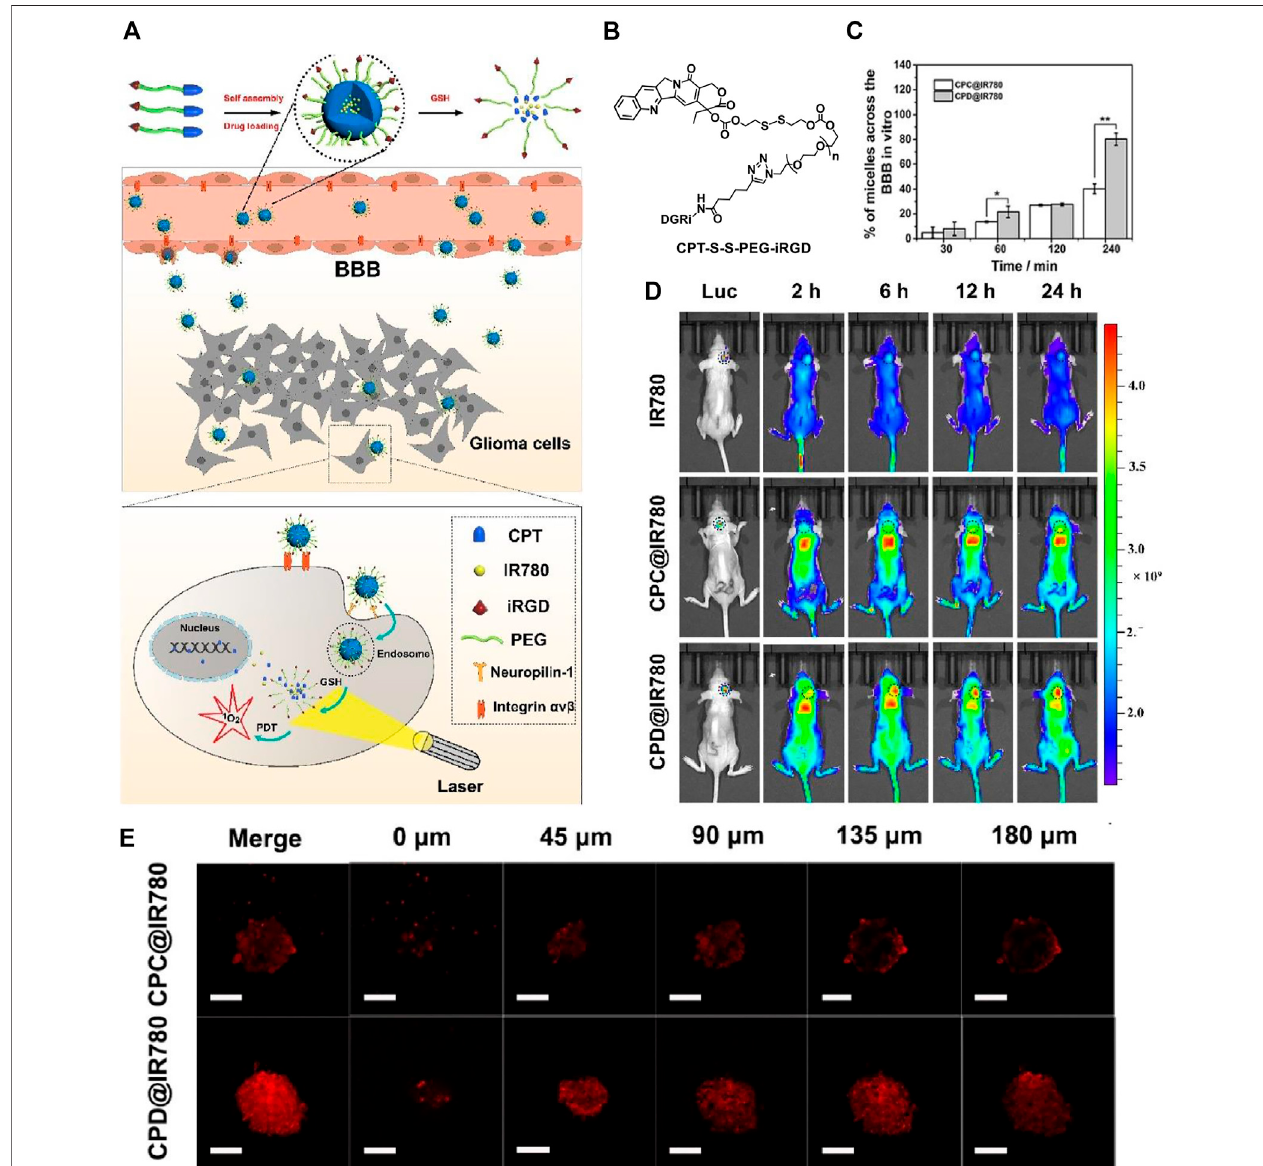
FIGURE 2 | (A) Preparation of self-assembled micelles, BBB penetrating, and glioma cell targeting by the iRGD peptide and GSH-induced disassembly for the combination of chemotherapy and photodynamic therapy; (B) molecular structure of CPT-S-S-PEG-iRGD; (C) the quantitative analysis of absorption spectra in the lowerchamberafterCPC@IR780micellesandCPD@IR780micelleswereculturedintheupperchamberfordifferenttimes; (D) wholebody fl uorescenceimagingofU87 orthotopic glioma mice at different time intervals. Dashed line indicates the glioma site; (E) intratumoral penetration characterization using U87 tumor spheroids treated with micelles in 45 μ m interval between consecutive slides. Reprinted with permission from Lu L. et al. (2020).